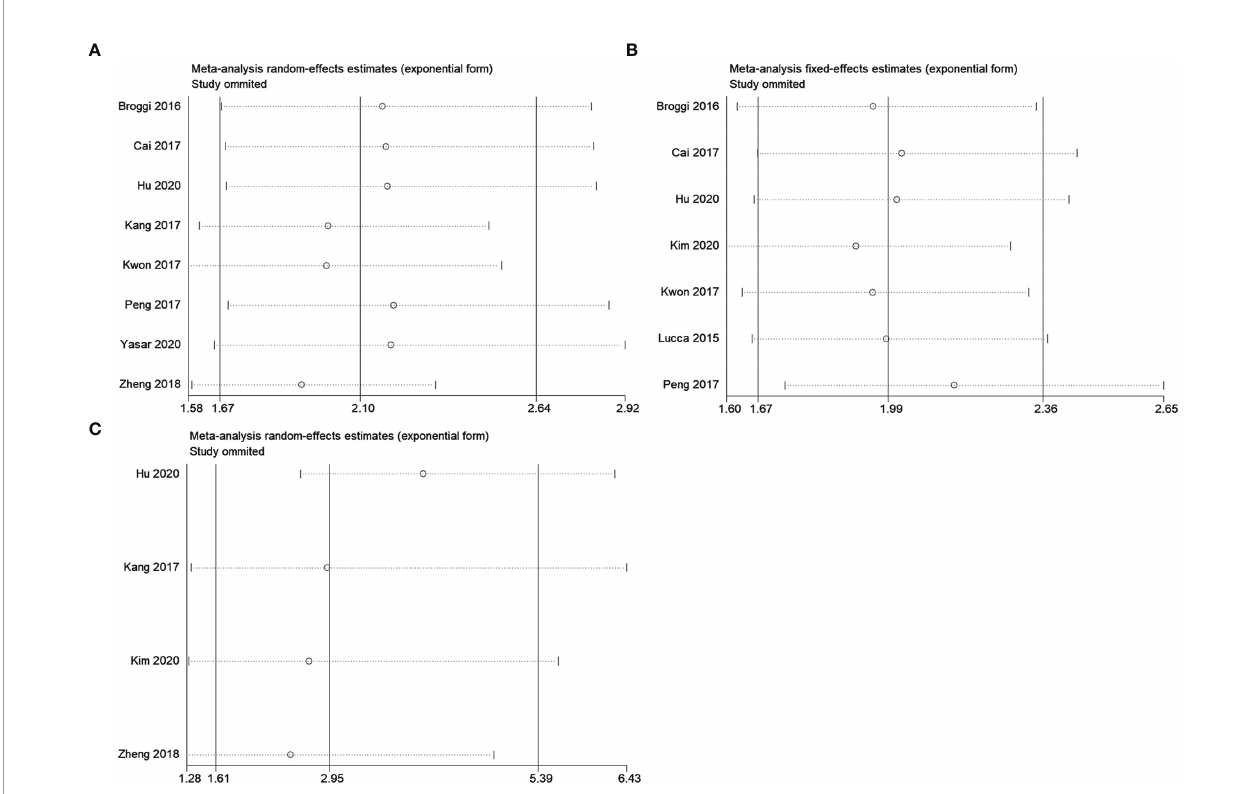
FIGURE 5 | Sensitivity analysis for (A) OS, (B) PFS/DFS/RFS, and (C) CSS in this meta-analysis.